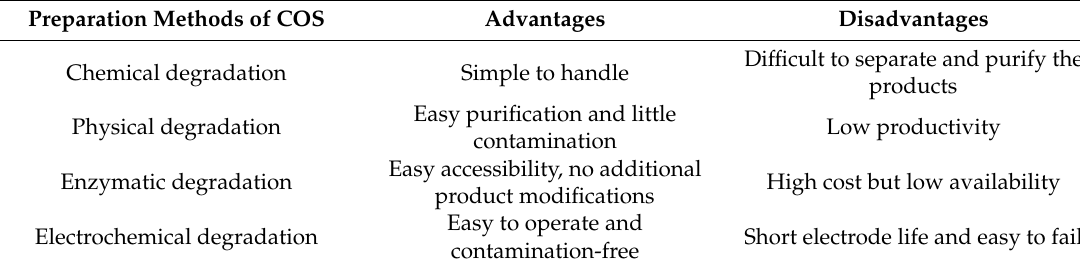
Table 1. The advantages and disadvantages of various preparation methods of